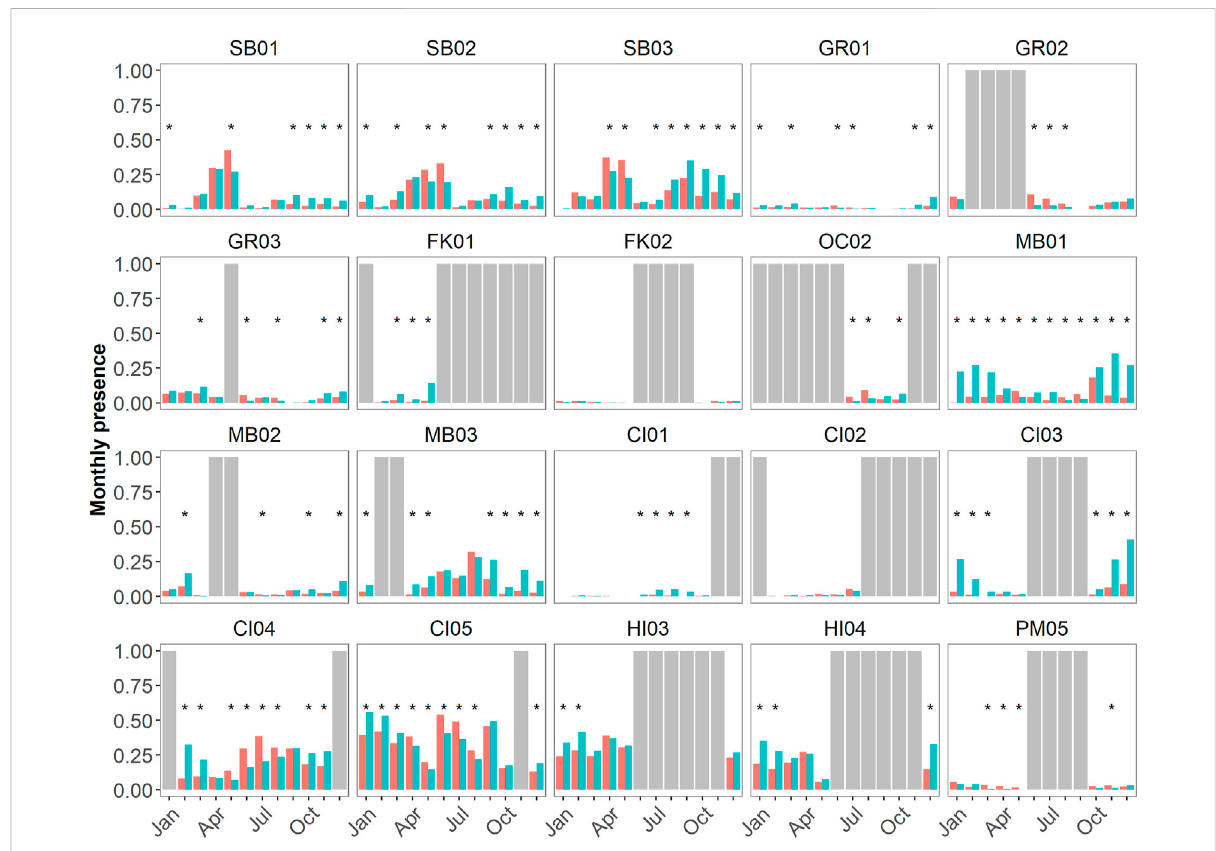
FIGURE 8 Diel proportional presence (as a ratio from 0 – 1) of hourly delphinid whistle presence from 1 June 2019 to 31 May 2020 across 19 passive acoustic recording sites within seven NMS, divided into three main regions: East Coast Region United States (US) — Stellwagen Bank National Marine Sanctuary (SBNMS), Gray ’ s Reef National Marine Sanctuary (GRNMS), Florida Keys National Marine Sanctuary (FKNMS); West Coast Region US — Olympic Coast National Marine Sanctuary (OCNMS), Monterey Bay National Marine Sanctuary (MBNMS), Channel Islands National Marine Sanctuary (CINMS) and Hawai ʻ i Region US — Hawaiian Islands Humpback Whale National Marine Sanctuary (HIHWNMS). The red bars represent daylighthoursandtealbarsrepresentnighttimehours(allhoursareinUTC).Monthsinwhichat-testforproportionsrevealedsigni fi cantdifferences at p < 0.05haveanasteriskabovethebars(*).Completemonthsinwhichnodatawascollectedareshownasgraybars,partialmonthswereincluded in this